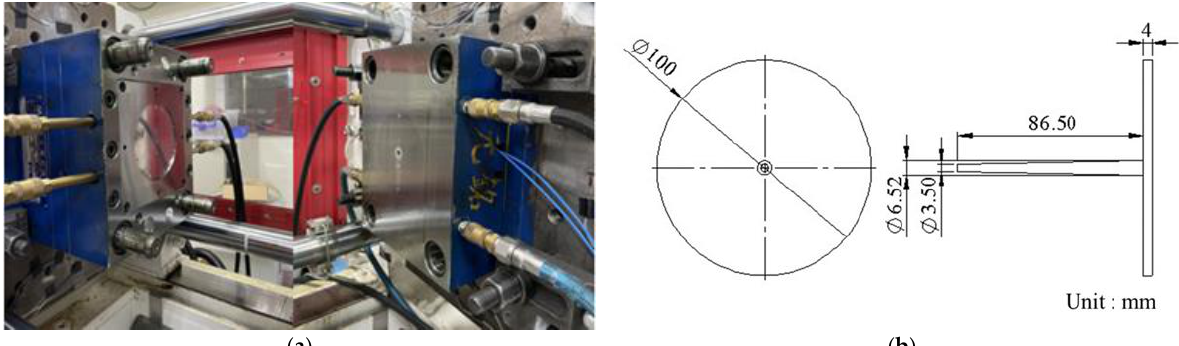
Figure 9. ( a ) Injection mold for the disk sample. ( b ) Dimensions of disk sample.